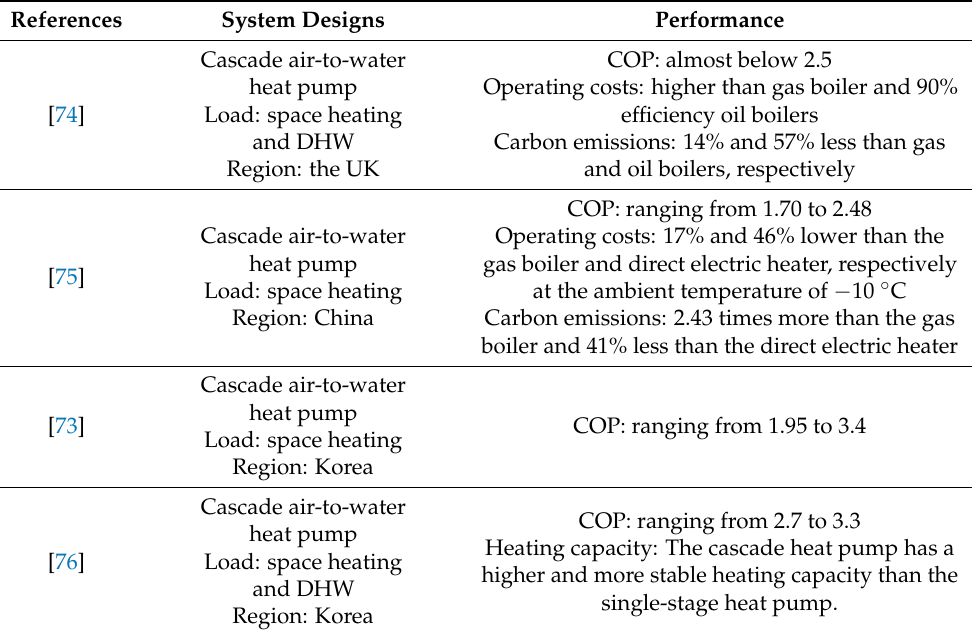
Table 5. Summary of studies of cascade air-to-water heat pump